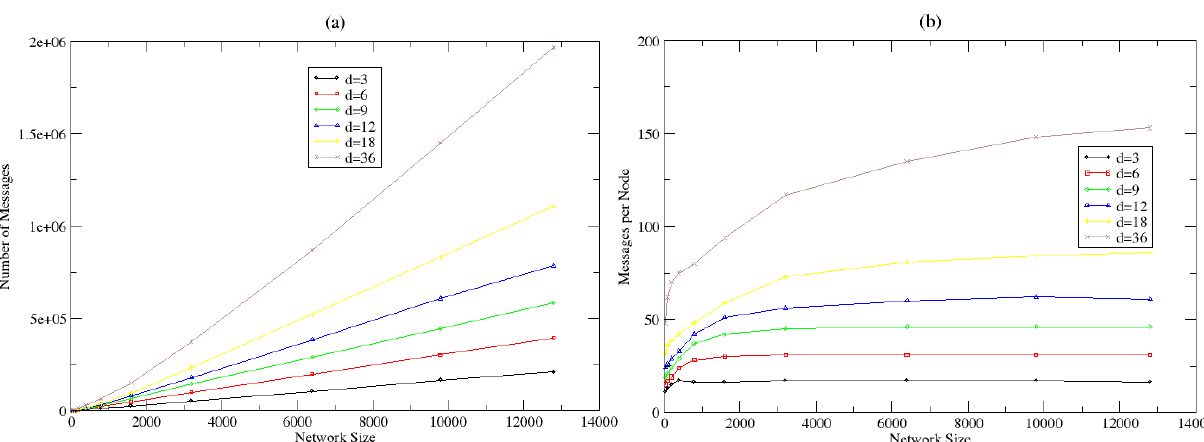
Figure 17 . (a) Total number of messages exchanged for cluster formulation and (b) total number of messages exchanged for cluster formulation per node.